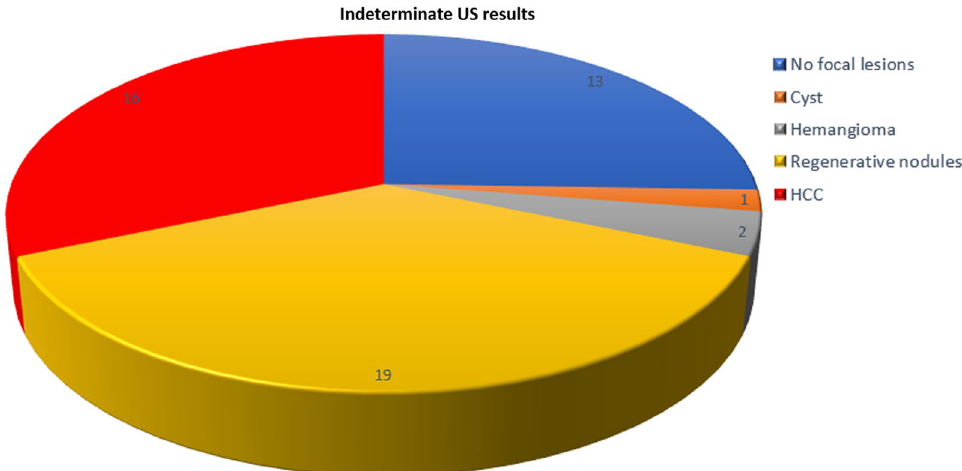
Fig. 4 Final results of indeterminate US findings